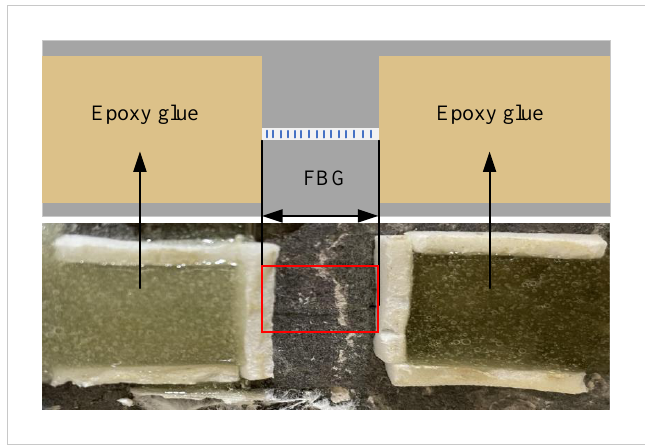
Figure 5. Diagram of the FBG strain sensor fixed on the structure.